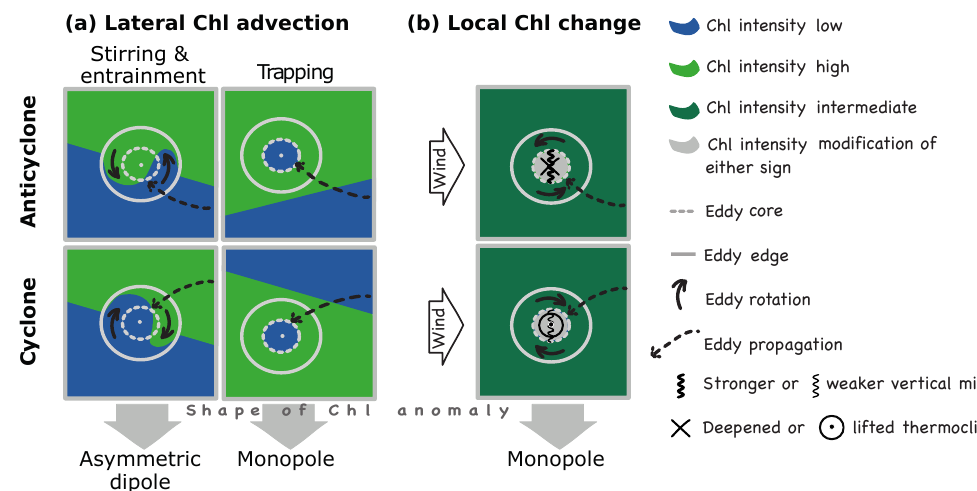
Figure 1. Schematic illustrating the mechanisms of how eddies may impact chlorophyll (Chl), for anticyclones (top row) and cyclones (bottom row), for the southern hemisphere; (a) shows the effects of advection (lateral displacements) of Chl due to the eddies’ rotational speed (stirring, left column) and lateral propagation (trapping, right column); trapping and stirring can cause δ Chl of either sign, depending on environmental Chl gradients; (b) shows multiple potential effects eddies may have on Chl by affecting biogeochemical processes. The local shape of δ Chl is anticipated to look different depending on the mechanism active, i.e., a monopole δ Chl is expected for all eddy-effects except for stirring where an asymmetric dipole is excepted (figure inspired by Siegel et al., 2011, Fig. 1).